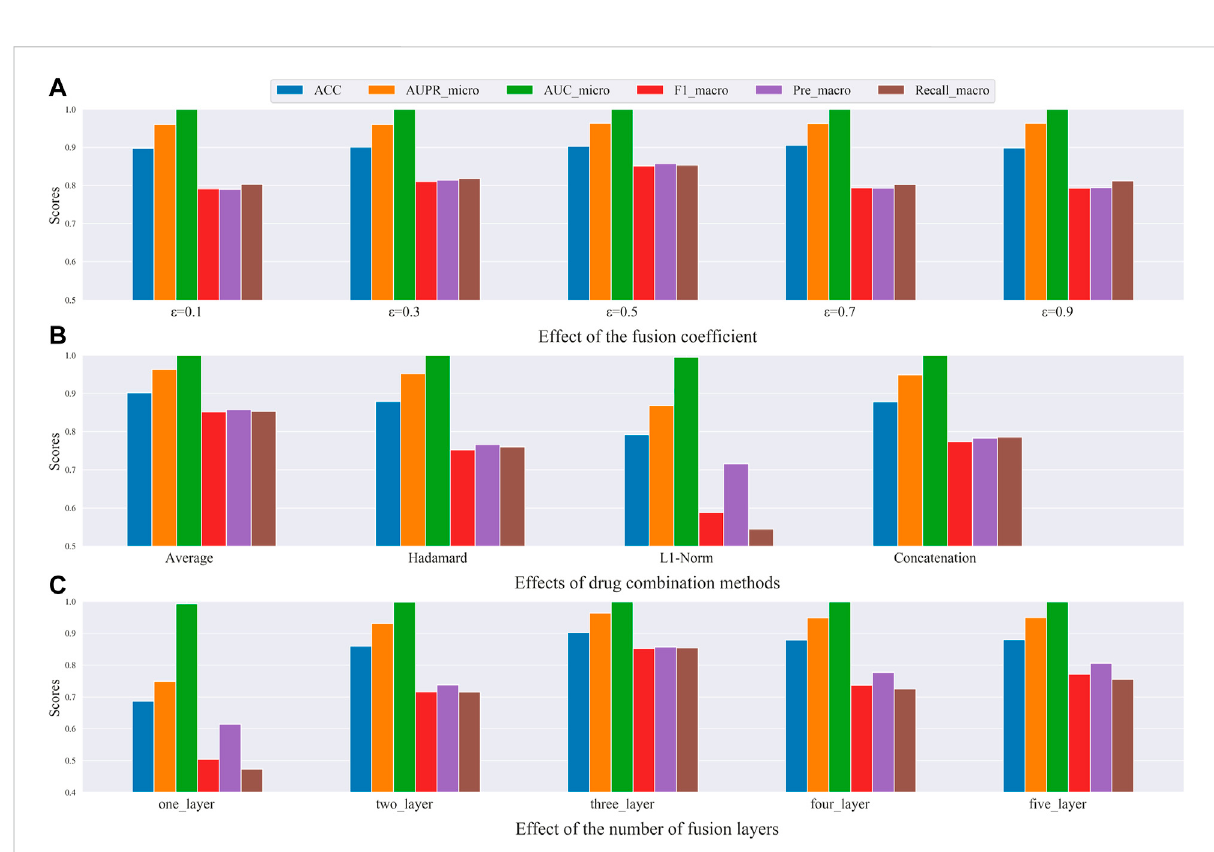
FIGURE 5 Results of ablation experiments. (A) Effect of fusion coef fi cient. (B) Effects of drug combination methods. (C) Effect of the number of fusion layers.